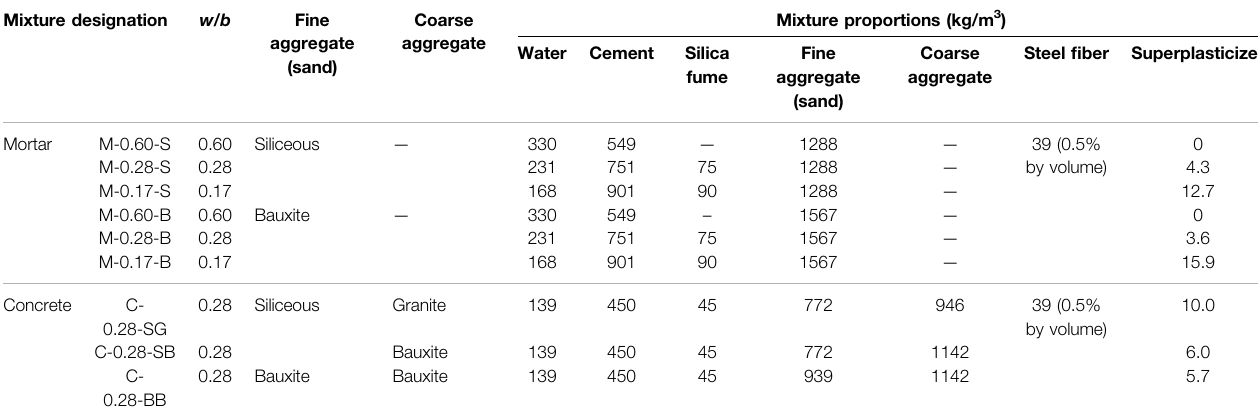
TABLE 2 | The mixture proportions of cement